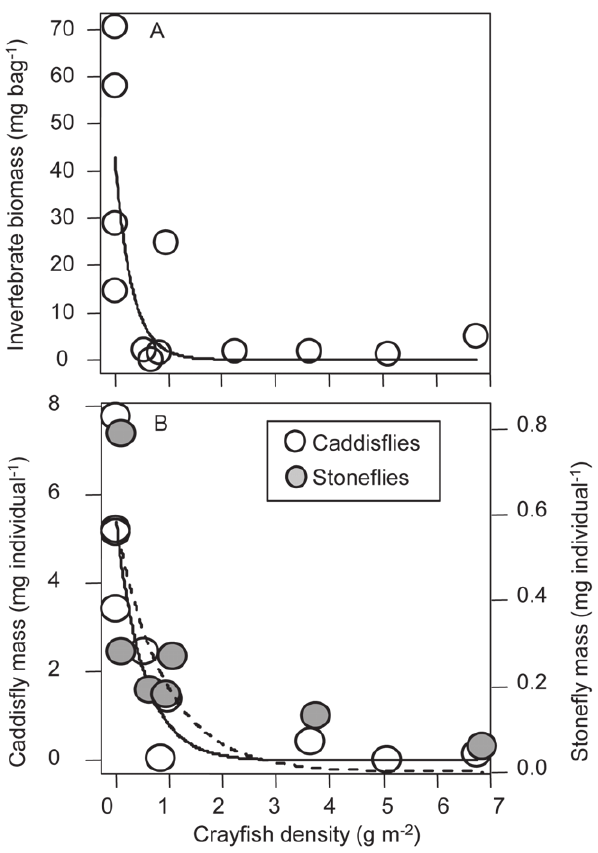
Figure 3. Invertebrate communities and the comparative study of crayfish. Each point represents the average for a study pool. (a) Invertebrate biomass (average biomass for coarse mesh leaf litter bags) as a function of crayfish density. Shown is the best fit exponential decay relationship (invertebrate biomass=42.7 * exp (crayfish * 2 3.2)). (b). Average individual invertebrate mass as a function of crayfish density. White symbols with the solid line are caddisflies (Tricoptera), corresponding to the left y-axis and gray symbols with the dashed line correspond to stoneflies (Plecoptera), corresponding to the right y- axis. If pools did not contain any individuals, these points are not shown.